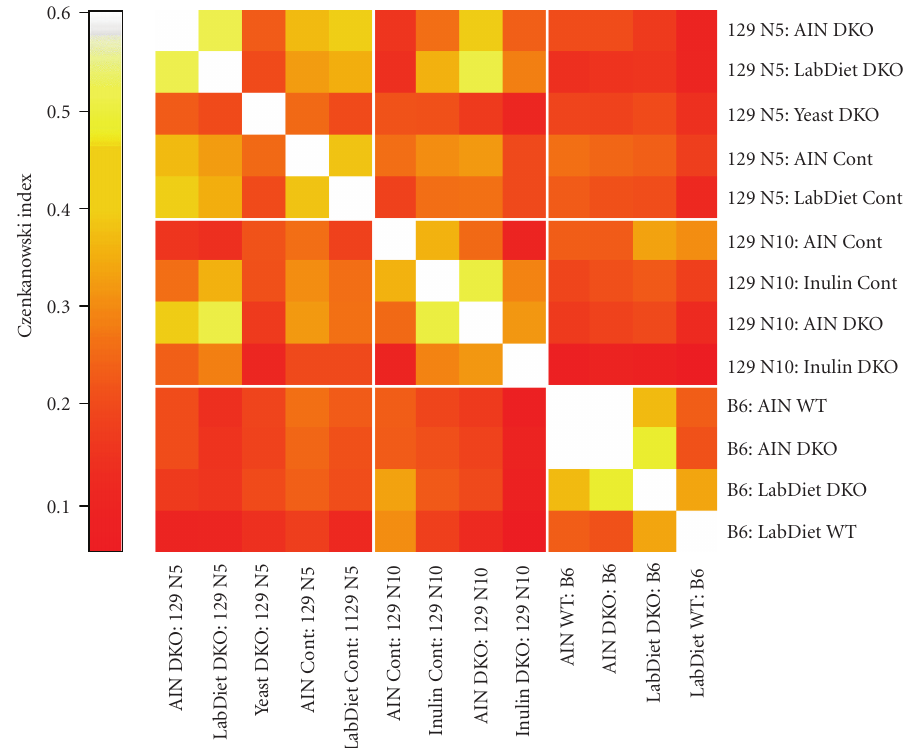
Figure 5: Heat map of Czekanowski similarity indexes of the ARISA profiles from Figures 4, 6, and 8. An index of 0.6 (white) is moderate similarity and an index of 0 (dark orange) is most distinct. “Cont” means the non-DKO sibs control of 129 DKO